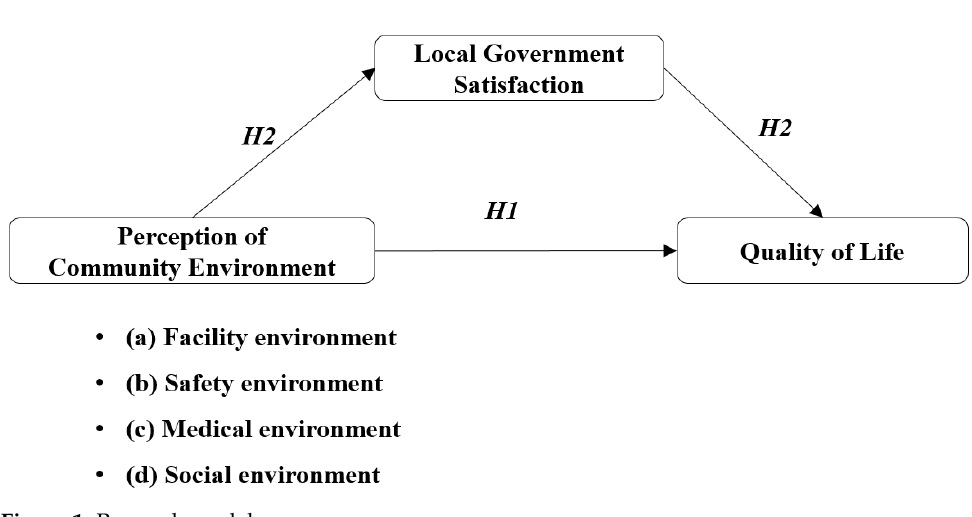
Figure 1. Research